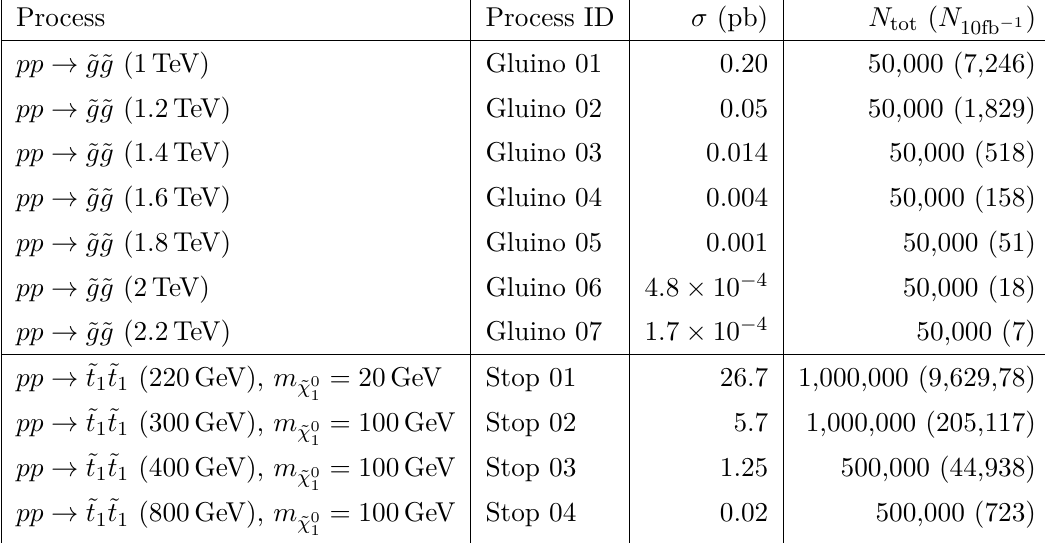
Table 1 . Summary of the supersymmetric benchmark models that are used to test our methods. √ The details include the production cross-section at s = 13 TeV, the number of events that were generated, and the number of events expected in 36 fb − 1 of LHC data